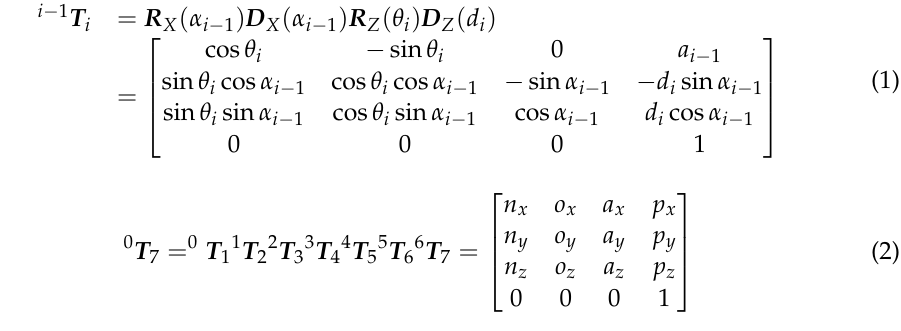
rotating angle α i − 1 from axis Z i − 1 to axis Z i around axis X i − 1 , distance d i * from axis X i − 1 to axis